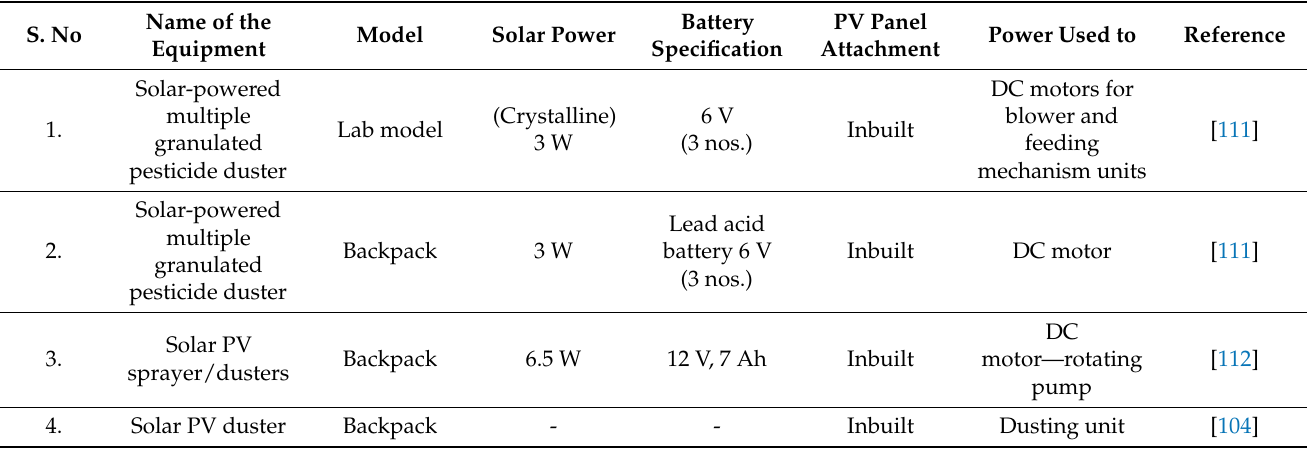
Table 4. Different types of solar-powered dusters.